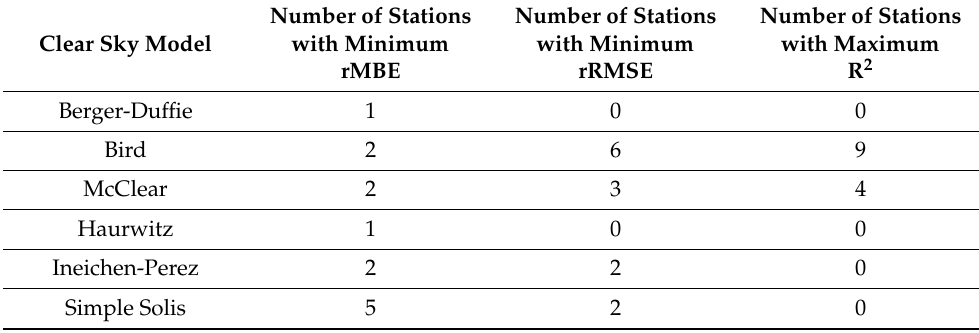
Table 4. Indication of number of stations with an optimum metric. Clear Sky Model